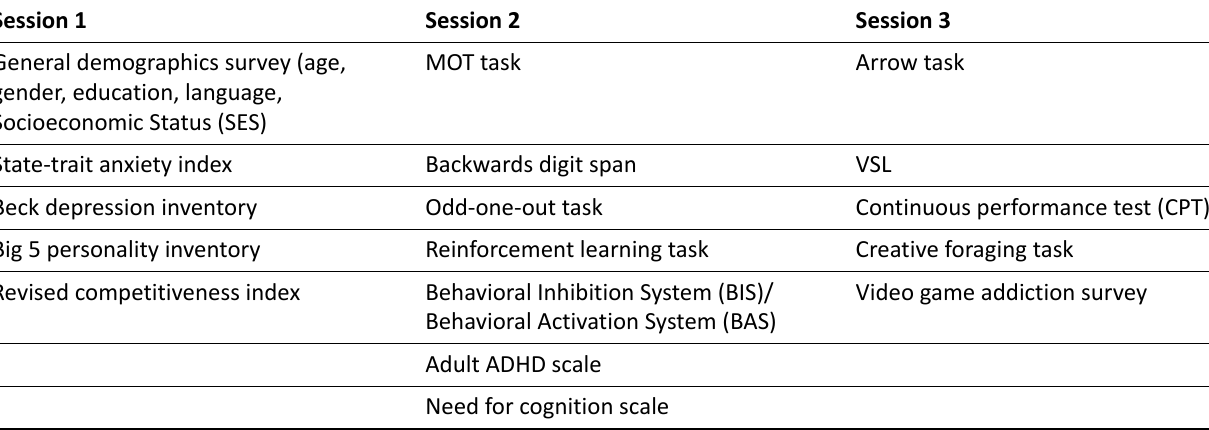
Table 1. The tasks and surveys completed by